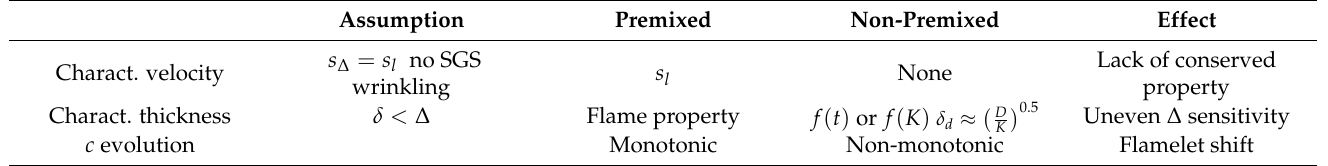
Table 1. Distinctive features between the premixed and non-premixed FTACLES.